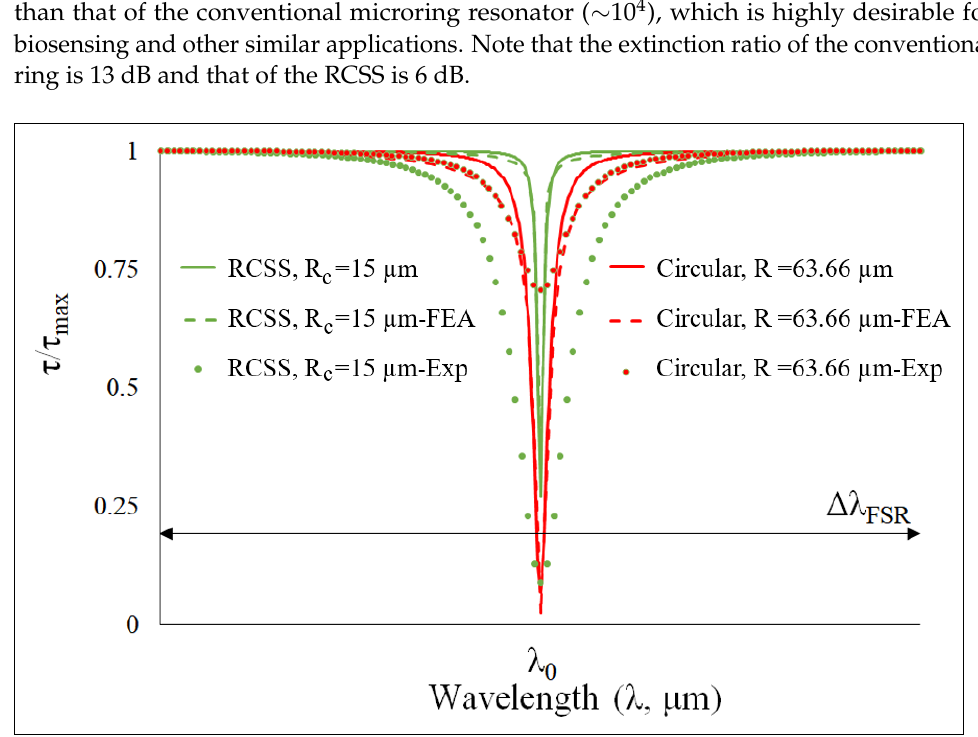
Figure 9. Comparison between the results obtained from the theoretical modeling, the FEA method, and optical experiments for (i) the RCSS microresonator with the optimal radius of curvature R c = 15 µ m (green) and (ii) the circular microring resonator (radius 63.66 µ m), keeping the optical path length at 400 µ m (red), TE